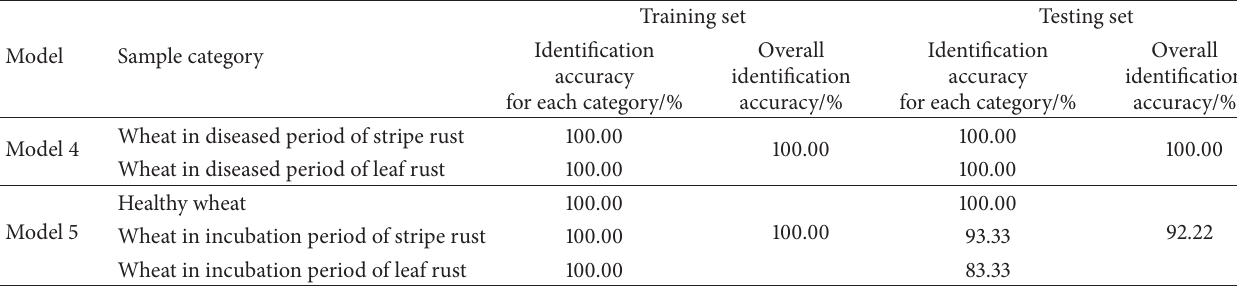
Table 3: The results of 𝐾 NN models for identification of wheat stripe rust and wheat leaf